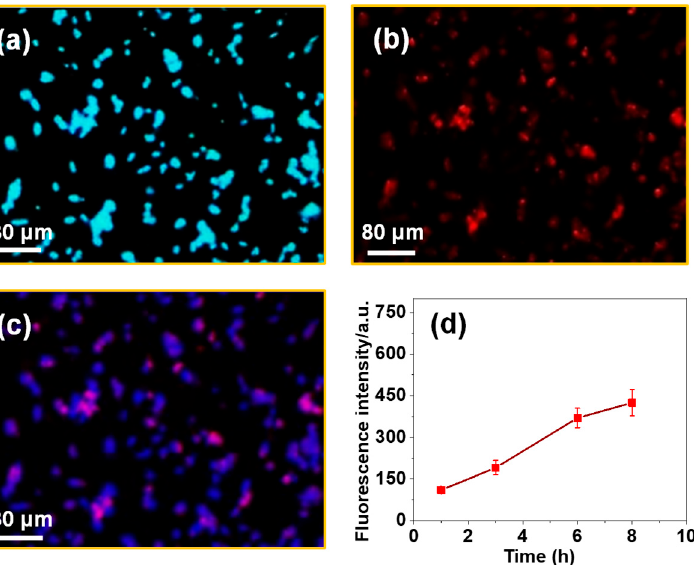
Figure 8. Fluorescence microscopy images of MDA-MB-231 cells treated with ( a ) a nucleus stain; ( b